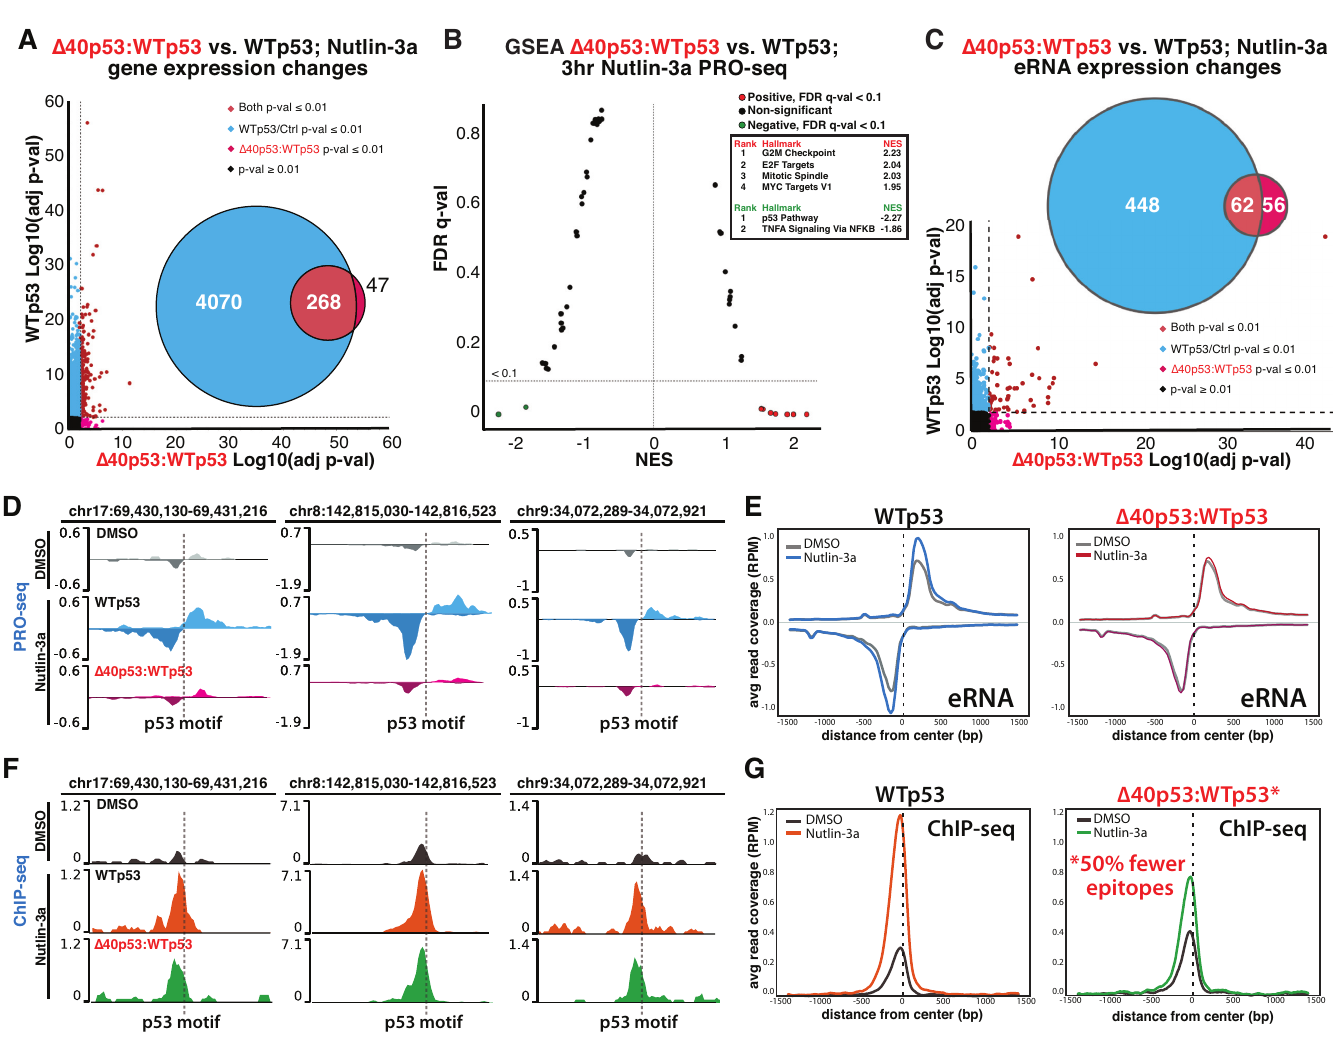
Fig 2. Δ 40p53 alters WTp53 function; Δ 40p53:WTp53 fails to induce eRNA transcription despite similar genomic occupancy vs. WTp53. (A) Summary of PRO- seq data for WTp53 (y-axis) vs. Δ 40p53:WTp53 (x-axis). Dashed line represents p -value 0.01. Venn diagram shows overlap between WTp53 and Δ 40p53:WTp53 cells. (B) GSEA based upon PRO-seq data (3 hours Nutlin-3a) comparing Δ 40p53:WTp53 vs. WTp53. Pathways with FDR (q-val < 0.1) are colored dots. Red represents increased in Δ 40p53:WTp53 compared to WTp53, and green is decreased. X-axis is NES. Top significant pathways are in the ranked list. (C) Summary of PRO-seq data of eRNA transcription for WTp53 (y-axis) vs. Δ 40p53:WTp53 (x-axis). Dashed line represents p -value 0.01. Venn diagram shows overlap between WTp53 and Δ 40p53: WTp53 cells. (D) Examples of PRO-seq data, showing Nutlin-induced eRNA transcription in WTp53 cells, but not Δ 40p53:WTp53. Location of p53 binding motif ( p - val � 1 × 10 − 5 ) indicated with dashed line. ( E) Metagene analysis showing average eRNA peak height, genome-wide, at p53-responsive eRNAs ( p -val < 0.25) in WTp53 or Δ 40p53:WTp53 cells. (F) Examples of ChIP-seq data in Nutlin-treated (6 hours) WTp53 or Δ 40p53:WTp53 cells, compared with DMSO controls; aligns with PRO- seq locations from panel D. (G) Metagene analyses showing average ChIP-seq signal, genome-wide, at p53 binding sites in control vs. Nutlin-treated WTp53 or Δ 40p53: WTp53 cells. Raw data for panels A–C, E, and G in S2 Data . ChIP-seq, chromatin immunoprecipitation sequencing; eRNA, enhancer RNA; FDR, false discovery rate; GSEA, gene set enrichment analysis; NES, normalized enrichment score; PRO-seq, precision nuclear run-on sequencing; WTp53, wild-type